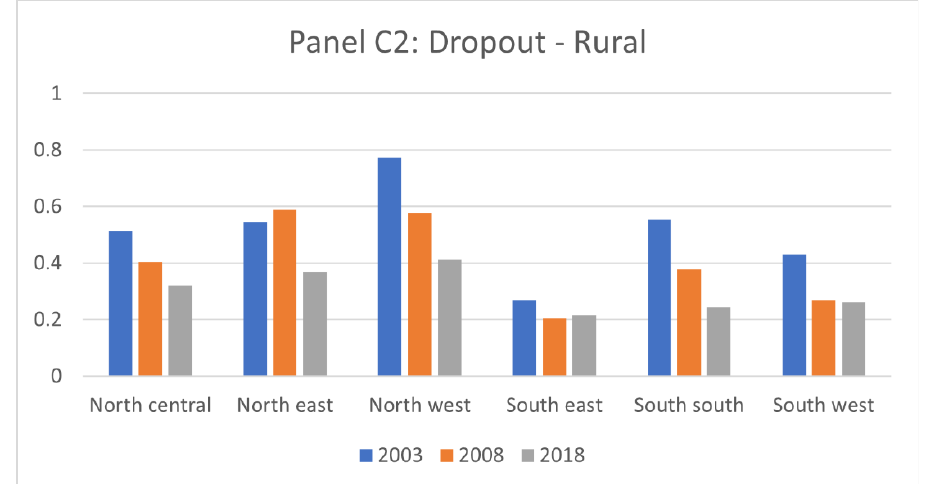
Figure 2. Prevalence of Children with Incomplete Vaccination Status: Zero-dose, Under-Immunized, and Dropout by Zone. Table 1. Correlation between the likelihood of children having incomplete vaccination status and sociodemographic